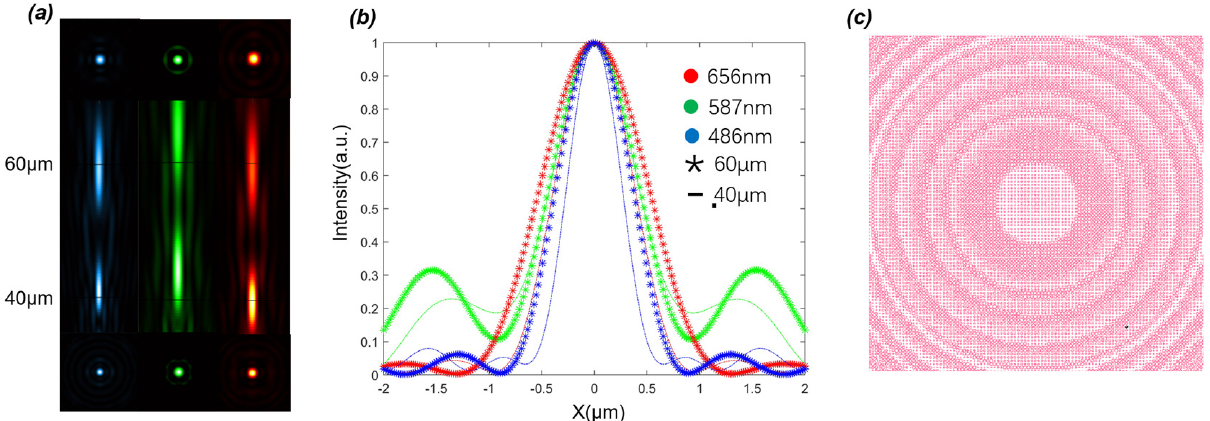
Figure 4. ( a ) Longitudinal intensity distribution and transverse intensity distribution simulated by B, G, and R wavelengths; ( b ) Transverse intensity distribution curve corresponding to the corresponding focal position; ( c ) The gds layout of the metalens structure.